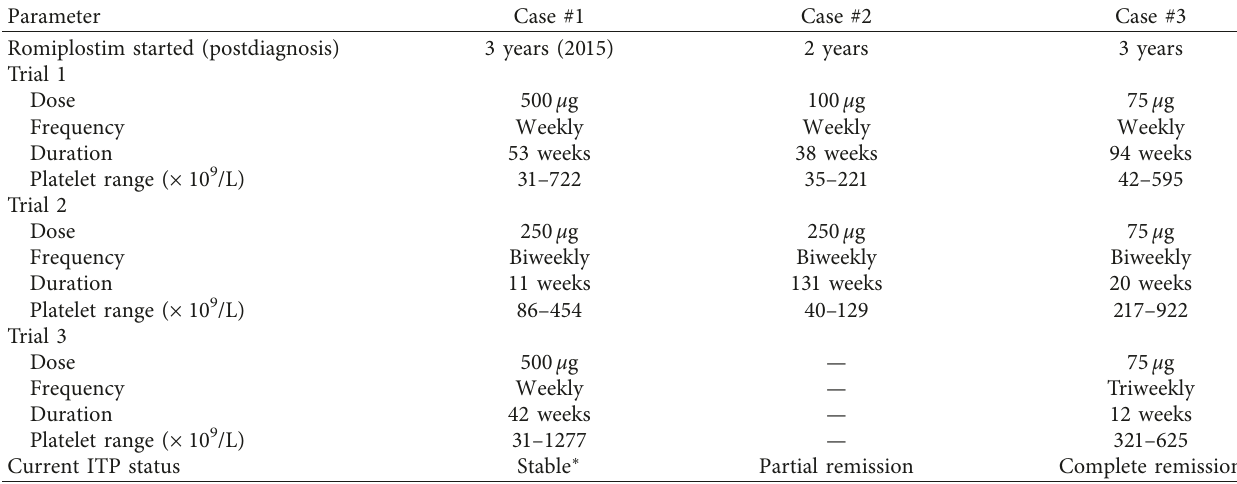
Table 2: Detailed summary of romiplostim dosing